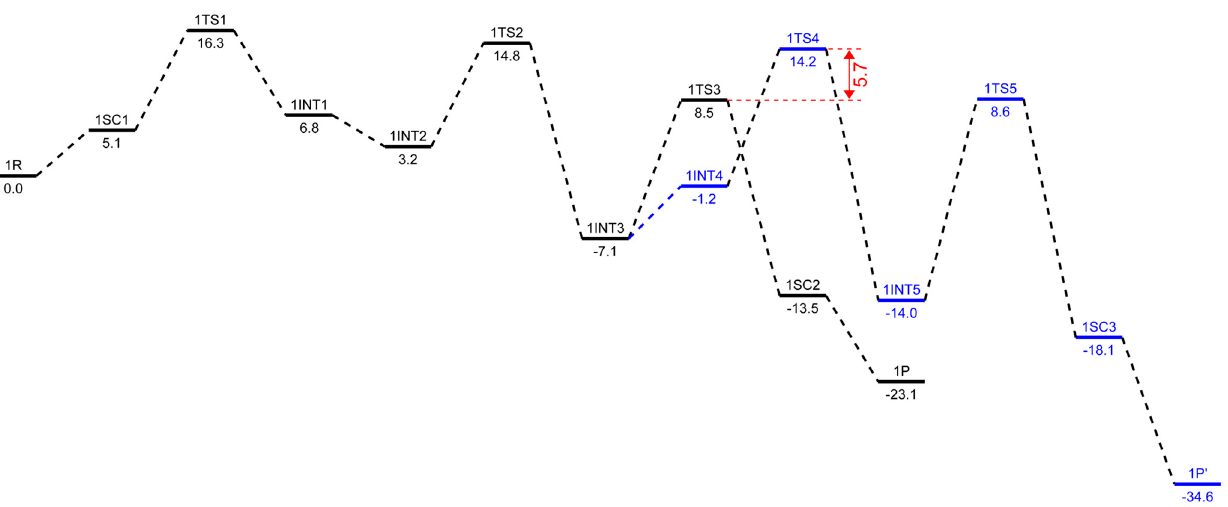
Figure 5. Corrected free energy profiles (in kcal/mol) at the level of B3LYP/6-311++G(d,p) with GD3BJ for ethylene trimerization in black and tetramerization in blue, using the ortho -methoxyaryl Cr-PNP catalyst. The SMD polarizable continuum solvent model was used for solvent effect correction.